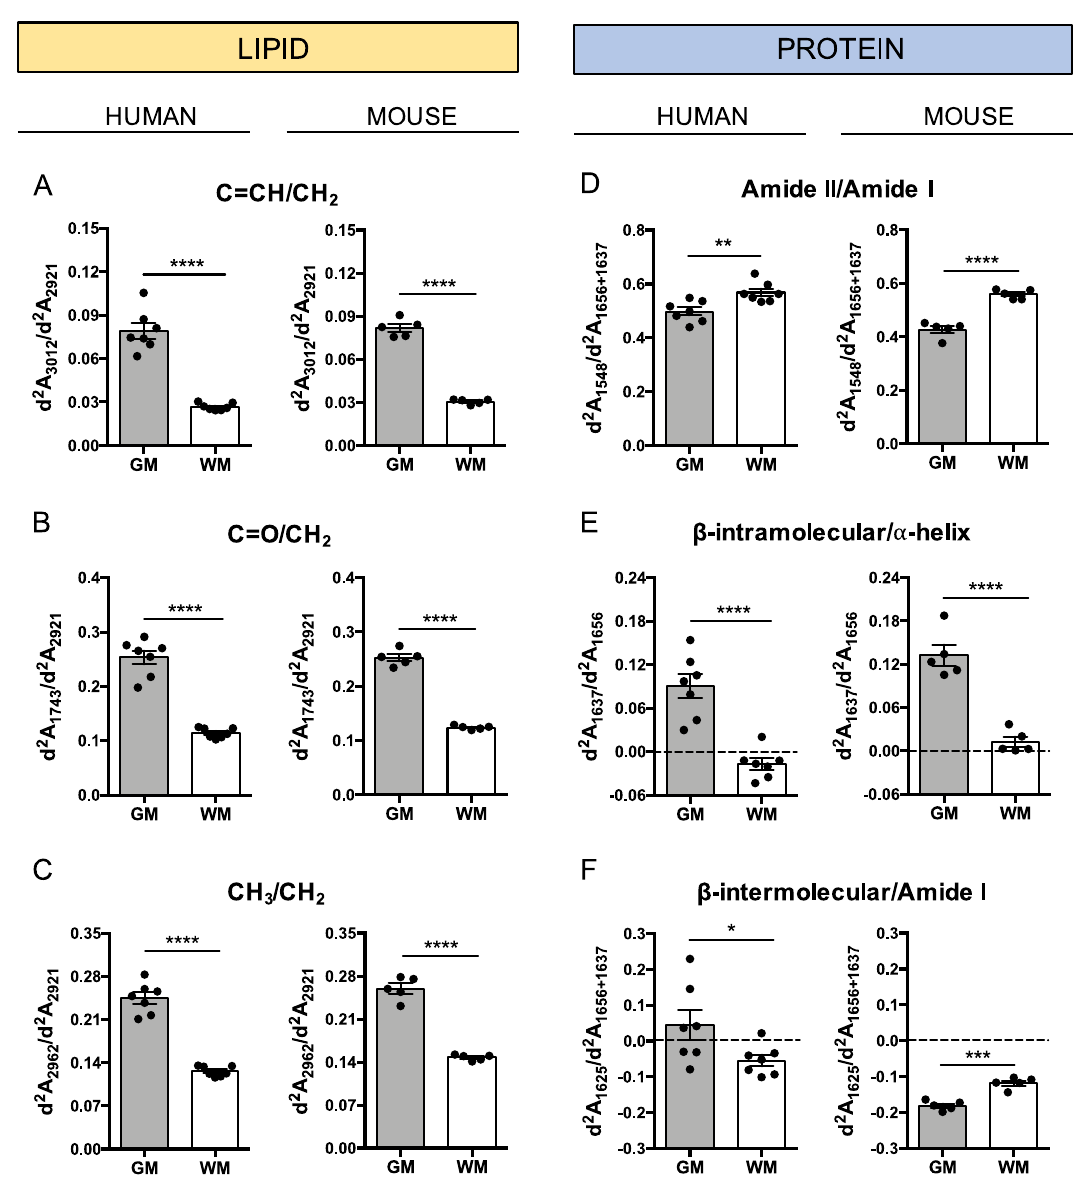
Figure 4. Chemical properties of lipids and proteins in grey matter (GM) and white matter (WM). Graphs represents absorbance second derivative (d 2 A) ratios of functional groups related to lipids ( A – C ) and proteins ( D – F ) in human and murine brain samples. Each dot in the graphs correspond to the mean of approximately 100 infrared measurements from a subject. * p -value < 0.05; ** p -value < 0.01; *** p -value < 0.001; **** p -value < 0.0001.